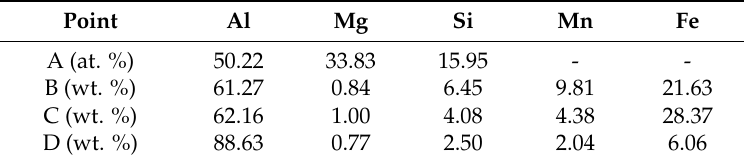
Table 5. EDX analysis results of the points indicated in Figure 8b (wt. % or at. %).